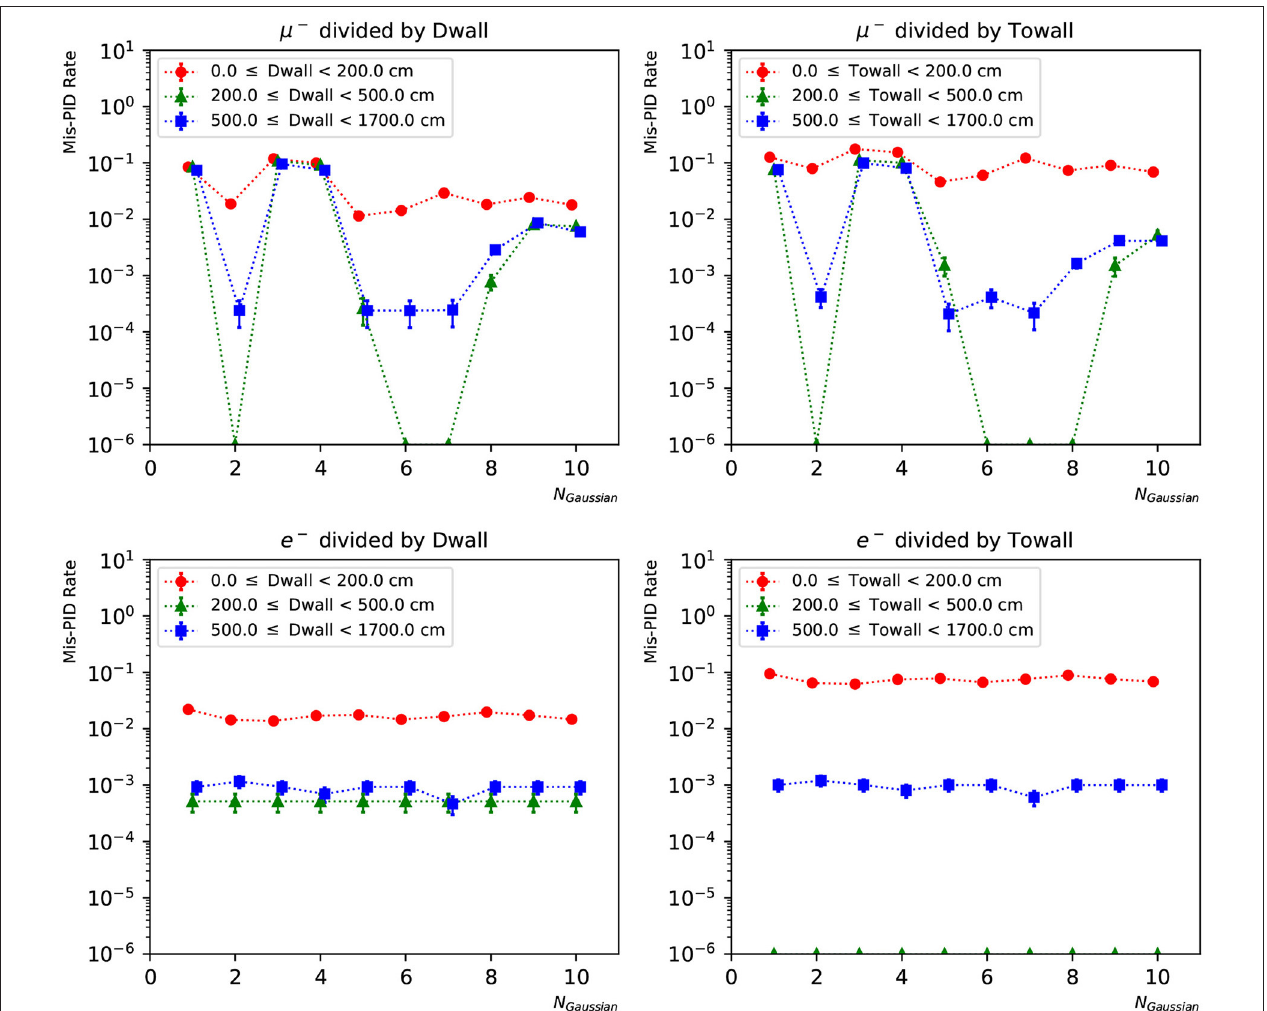
FIGURE 12 | The particle mis-identification rate of charge-only networks with 1 0 200, 200 500, and 500 cm from the detector walls. The left column shows dependence of “dwall” and the right “towall”. Statistical errors are also ∼ ∼ ≥